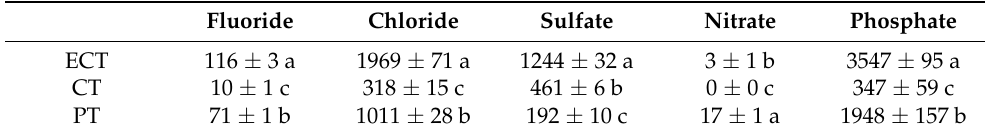
Table 4. Fluoride, chloride, sulfate, nitrate, and phosphate content of energy cane juice (ECT), corn (CT), and corn plus energy cane (PT).